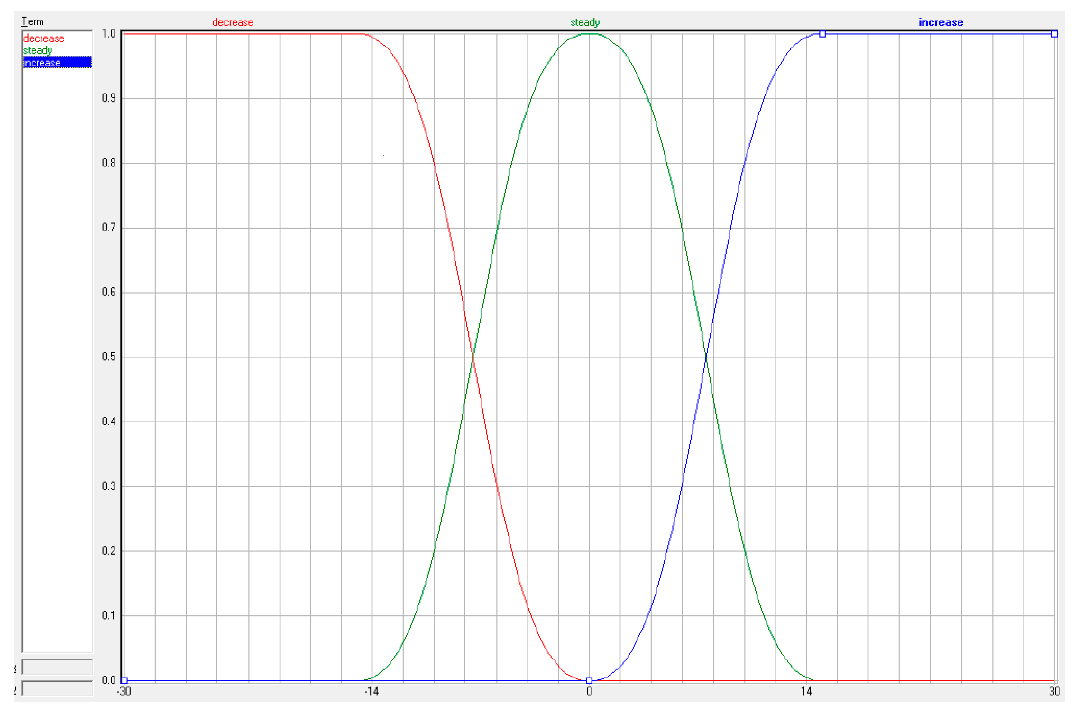
Figure 3. Fuzzy sets for the variable “X4”—the growth rate of the GDP with membership functions. Source: based on the Figure 4. Defined membership functions for the variable “output” representing the forecast of the author’s own trends in the volume of nonperforming loans. Source: based on the author’s own studies.